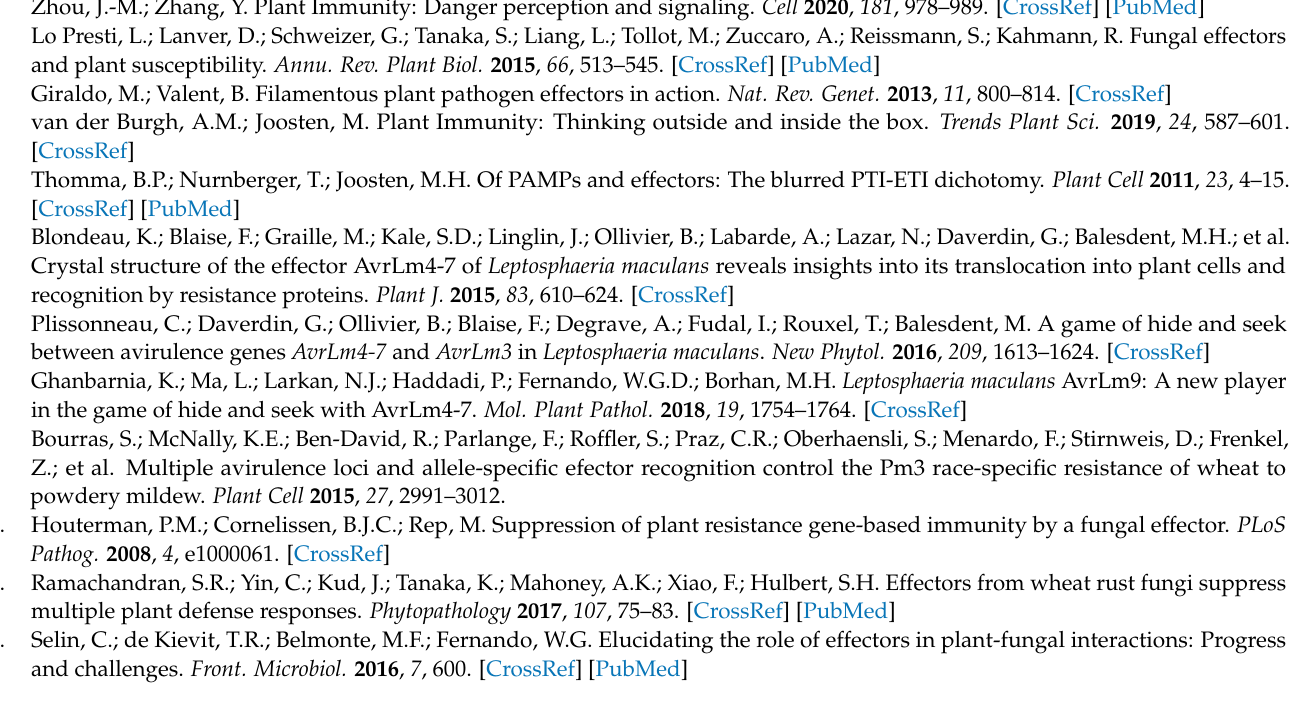
Figure S3. RT-PCR to check the expression of 22 cloned effector candidate genes in agroinfiltrated N. benthamiana leaves; Figure S4. FolEC-14 and Eol-EC20 are not able to inhibit L6TIR - and Fol-EC19 - induced cell death in N. benthamiana leaves; Figure S5. PaGluc131A alignment; Figure S6. Fol-EC14 alignment; Figure S7. ChGluc131A alignment; Figure S8/ChGluc131B